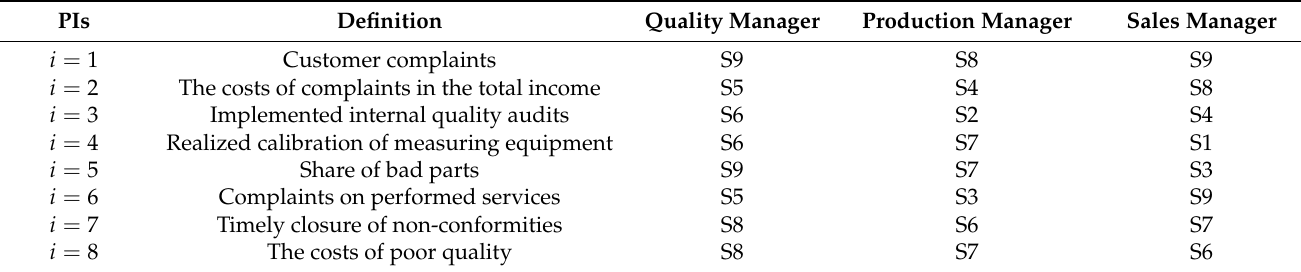
Table 5. Assessment of the relative importance of performance